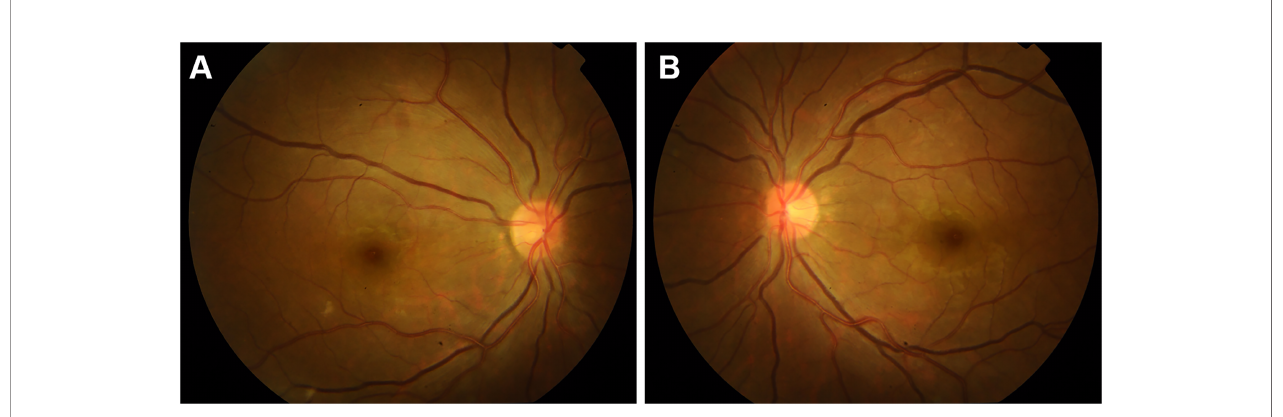
FIGURE 1 | Retinal fundus photographs before surgery showing mild venous dilation in the right eye (A) and the left eye (B)